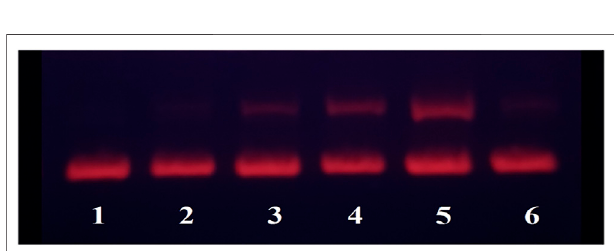
FIGURE 2 | Agarose gel electrophoresis of pBR322DNA (0.1 μ g) with different concentrations of the Fe complex. Lane 1: DNA only; Lane 2: 0.1 μ